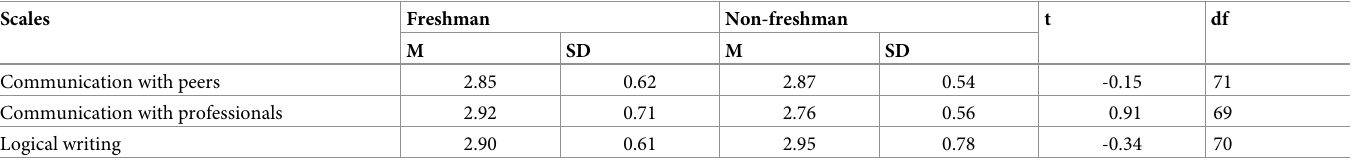
Table 3. Descriptive statistics and t -test results for language challenges (freshmen vs. non-freshmen). Scales